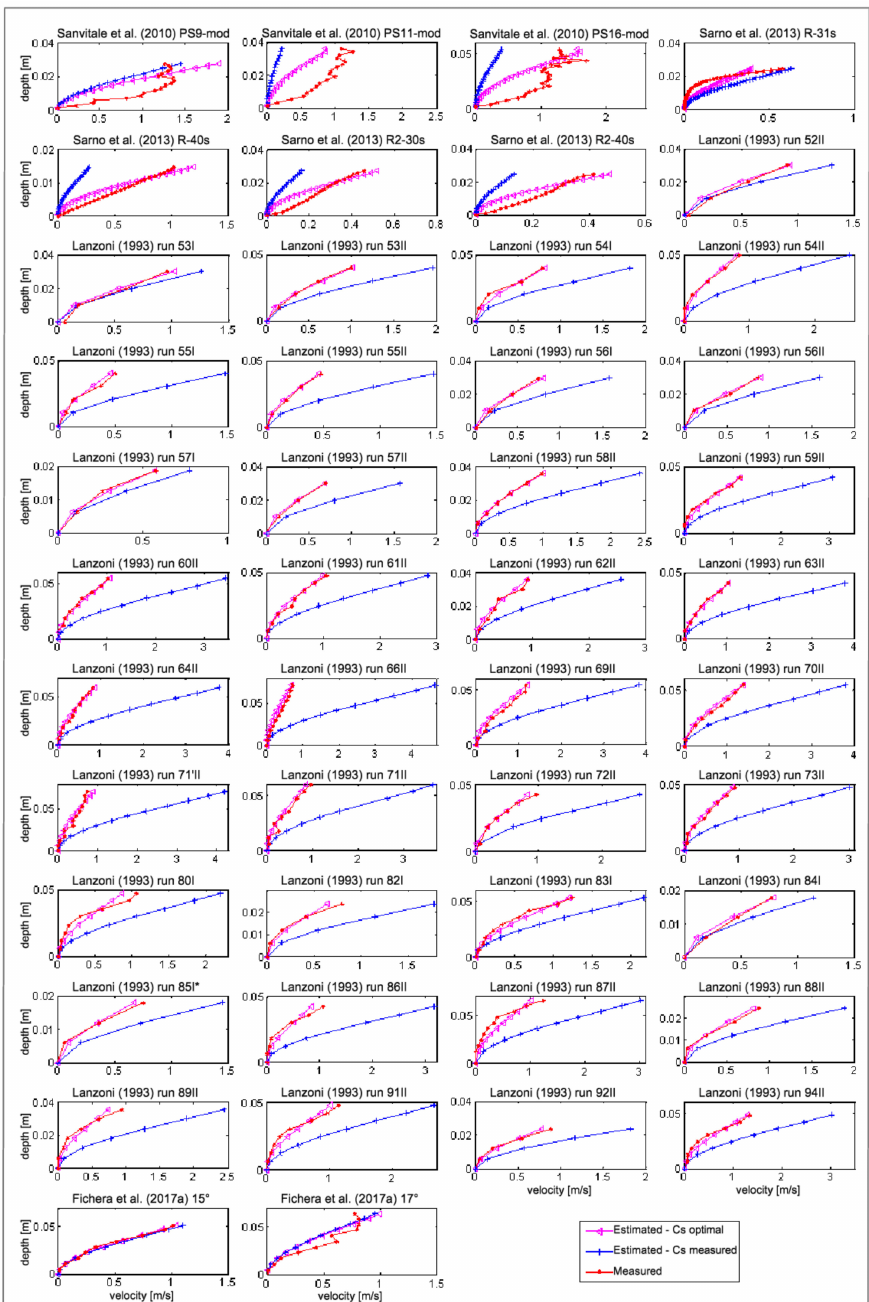
Figure 13. Comparison between the estimated velocity profiles and those taken from the